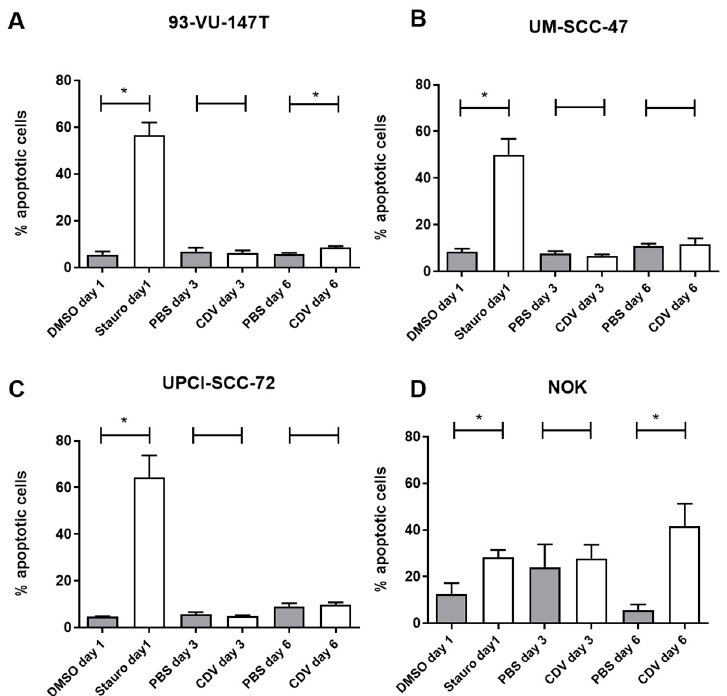
Figure 6. Effect of CDV treatment on induction of apoptosis. Cells were either treated for 1 day with 1 µ M Staurosporine, a known inducer of apoptosis or for 3 and 6 days with CDV, followed by analysis of Annexin V staining. Results are shown for ( A ) 93-VU-147T, ( B ) UM-SCC-47, ( C ) UPCI-SCC-72 and ( D ) NOK. Statistical significance was indicated as follows: p < 0.05 (*). The experiments were performed in triplicate.